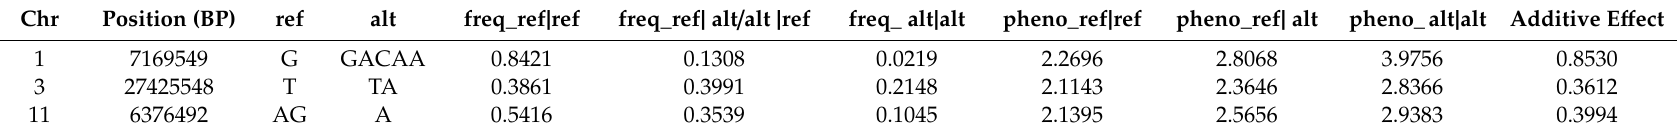
Table 3. Allelic frequency, phenotypic mean, additive e ff ect of significant